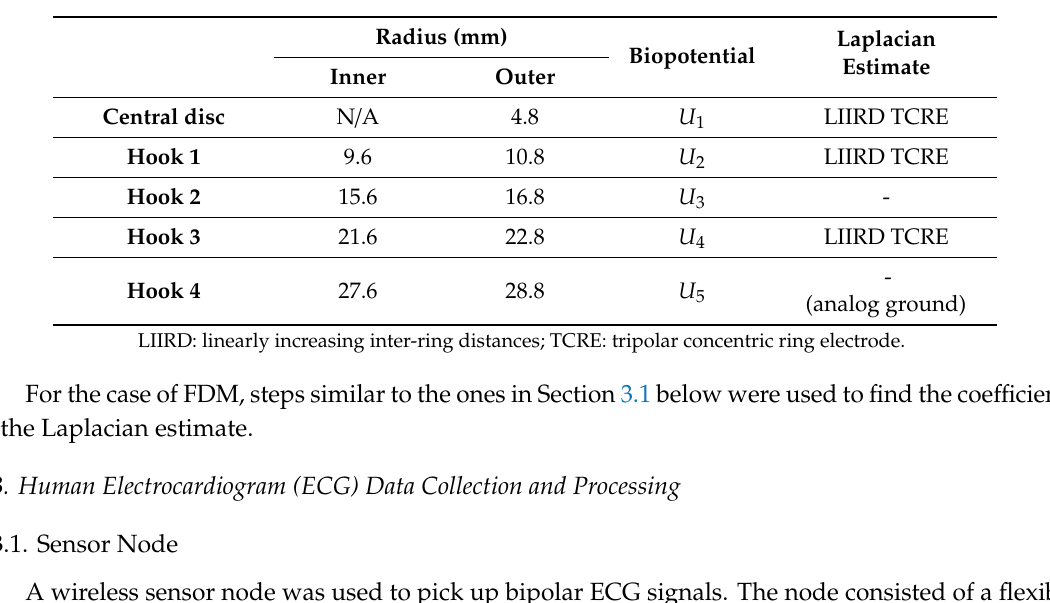
Table 2. Concentric ring electrode (CRE) dimensions and nomenclature of the biopotentials used for Laplacian estimation.